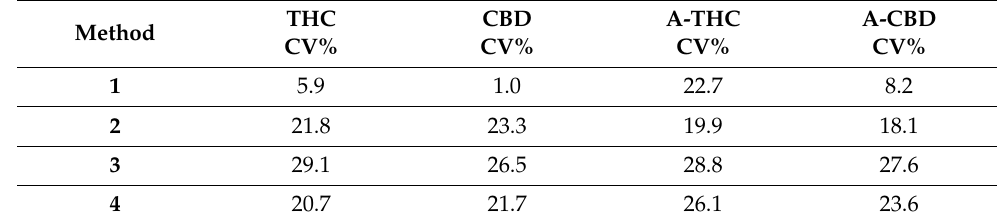
Table 1. (CV%) of the different dilution schemes, with pipettes 1.